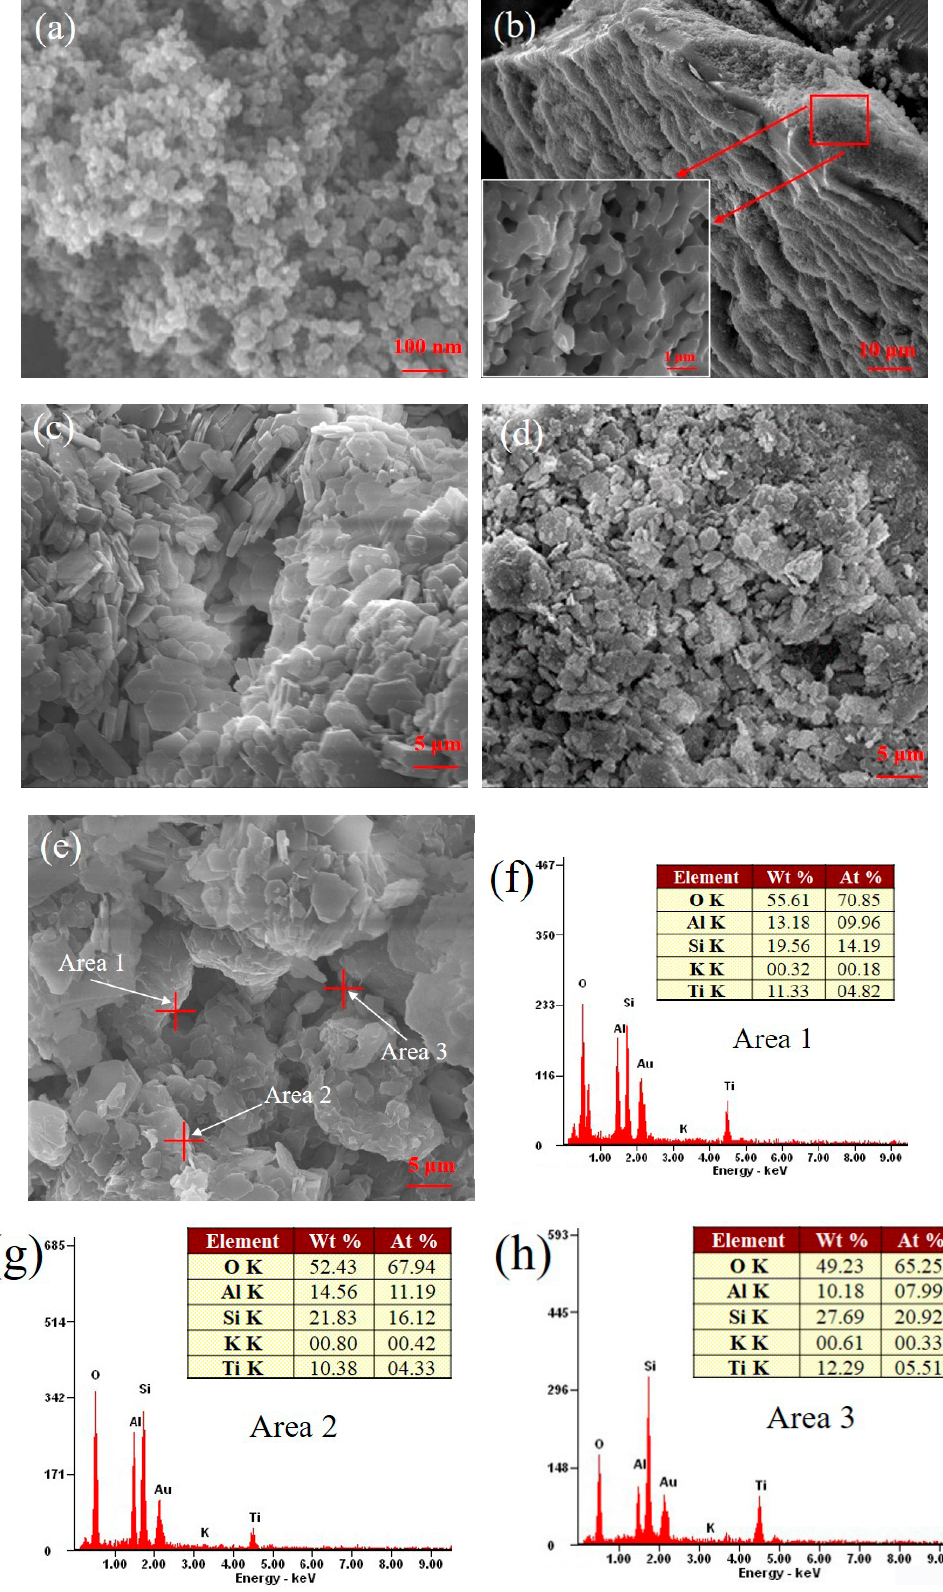
Figure 2. Scanning electron microscopy (SEM) images: ( a ) P25; ( b ) HTOP; ( c ) NZ; ( d ) MZ; ( e ) MZTC-2.5; energy dispersive spectroscopy (EDS) results of MZTC-2.5: ( f – h ).